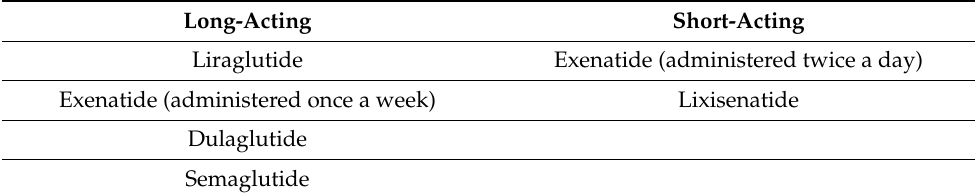
Figure 1. Vascular complications in diabetic patients [4,5]. Table 1. Classification of GLP-1 receptor analogues [8,9].